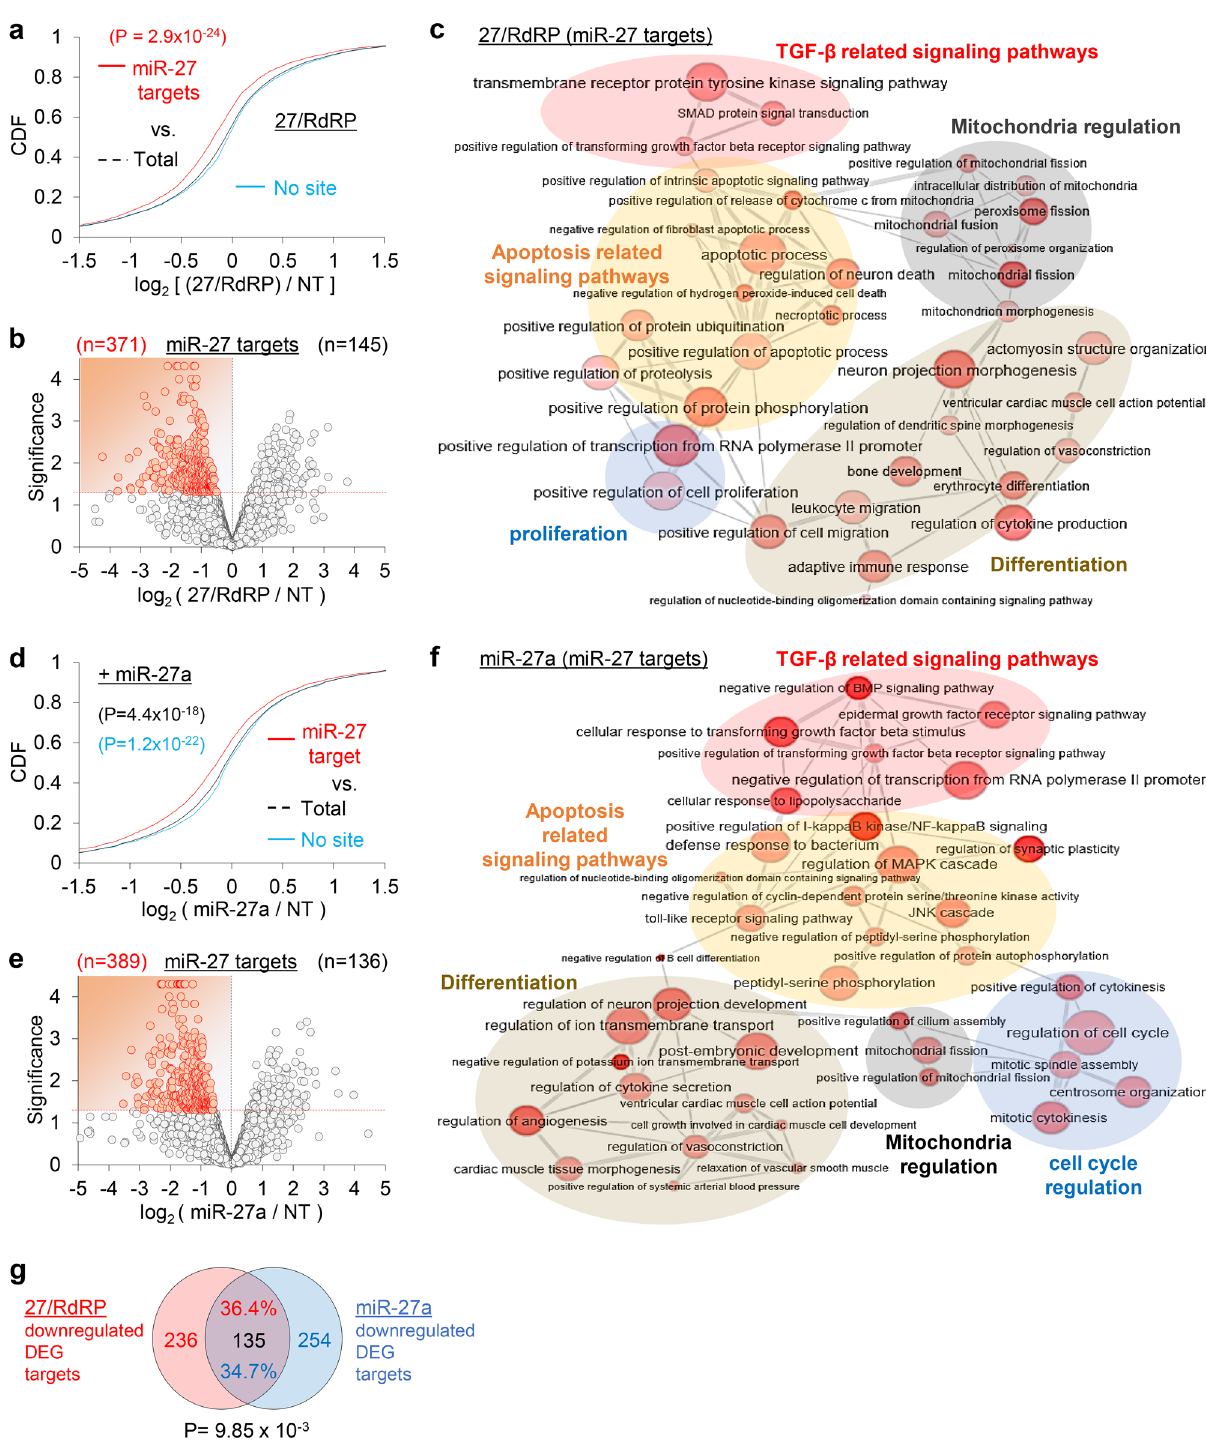
Figure 4. Transcriptome-wide assessment of miRNA-like activity in 27/RdRP. ( a ) RNA-Seq analyses were performed in 27/RdRP- transfected A549 cells. CDF analysis using RNA-Seq for putative miR-27 targets, that harbour 7mer-A1 seed sites (an exact match to positions 2–7 followed by an ‘A’ at position 1) in their 3 ′ UTRs, according to their fold changes (log2 ratio; relative to the non-targeting miRNA, ‘NT’, negative control); RPKM values from Cufflinks; P -values from Kolmogorov–Smirnov test (two-sided) relative to the total transcripts (Total); ‘No site’, transcripts with no 6mer seed matches (positions 2–8). ( b ) Volcano plot analyses of the putative miR-27 targets, which contain 6mer seed site (positions 2–7) in 3 ′ UTR, in the presence of 27/RdRP expression; significance, − log 10 ( P -value); downregulated differentially expressed genes (DEG, P < 0.05; Cuffdiff), highlighted in red. ( c ) GO analysis results of the downregulated DEGs in 27/RdRP transfected A549 cells, which are presented as networks of enriched biological process terms (EASE score < 0.2, DAVID; node size and colour intensity inversely correlate with P -value). Only clusters of graphs with high connections are displayed. ( d–f ) Same analyses as conducted in ( a – c ) except for miR-27a-transfected A549 cells. ( g ) Significant overlap (upper panel, n = 489) in the differentially downregulated targets between 27/RdRP ( b ) and miR-27a ( e ) expression ( P = 9.85 × 10 –3 ; chi-square test, relative to random shuffling in Supplementary Fig. S3c); details in the Material and methods